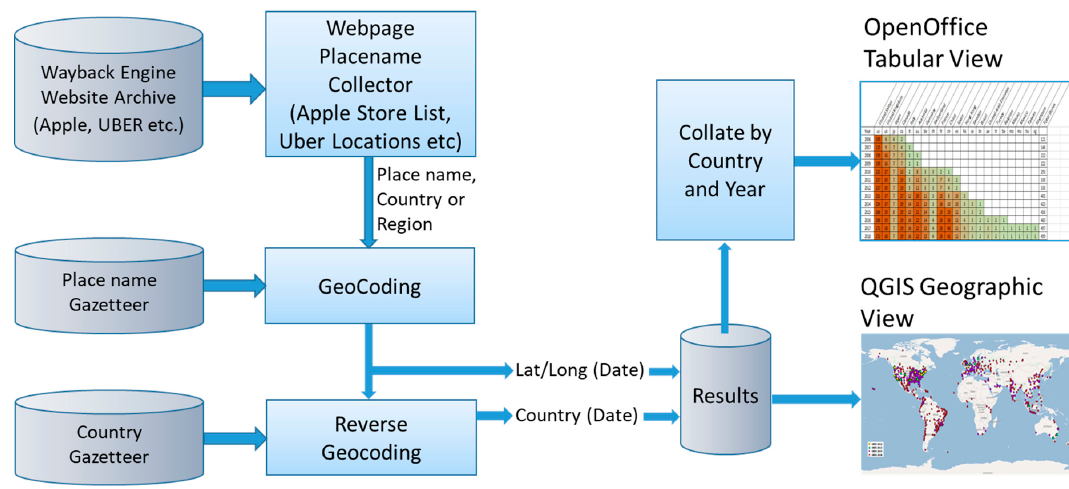
Figure 11. Store location capture experimental architecture.